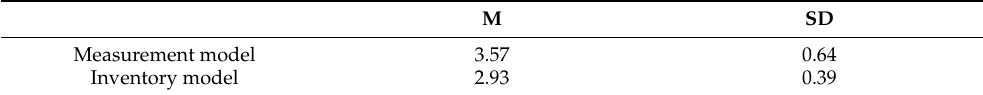
Table 3. Descriptive indicators of the measurement and inventory models.